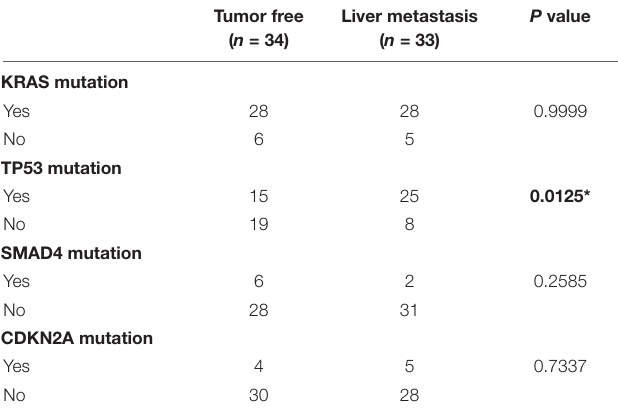
TABLE 3 | Patient mutation characteristics from TCGA.